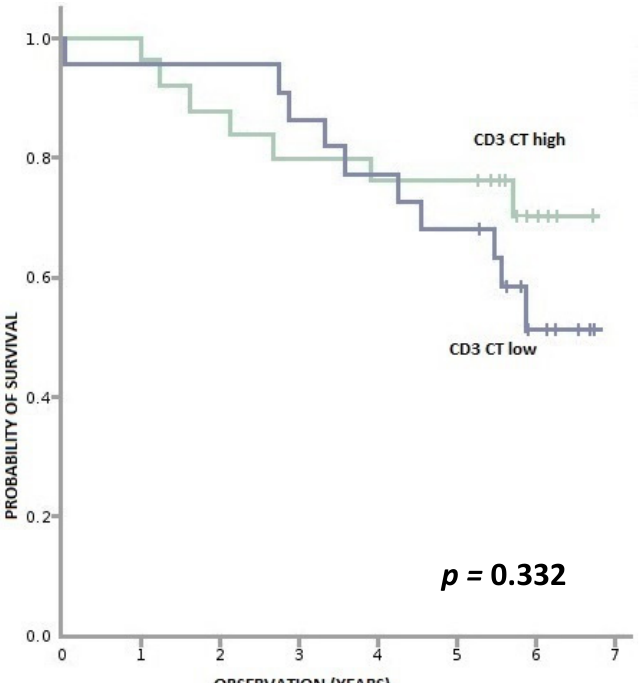
Figure A3. Overall survival according to density of CD3+ lymphocytes in CT (tumor center). CD3+ CT high— ≥ 840 per 0.56 mm 2, CD3+ CT low—<840 per 0.56 mm 2.